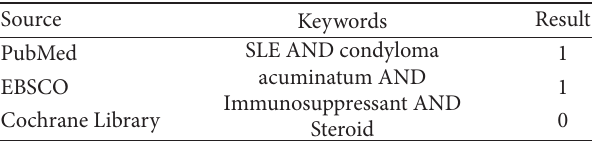
Table 1: Literature